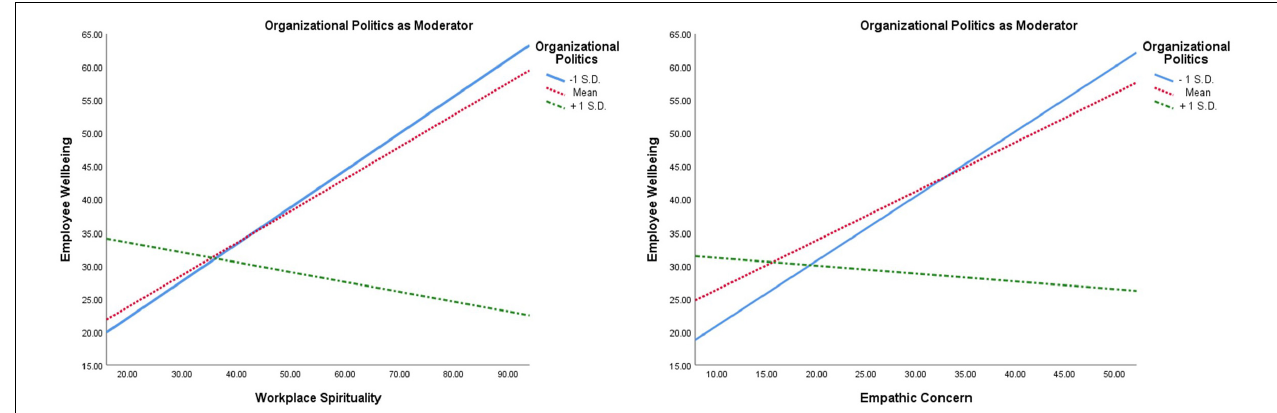
FIGURE 2 | Graphical illustration of the moderation effect of organizational politics on the relationship between workplace spirituality and employee wellbeing; and empathic concern and employee